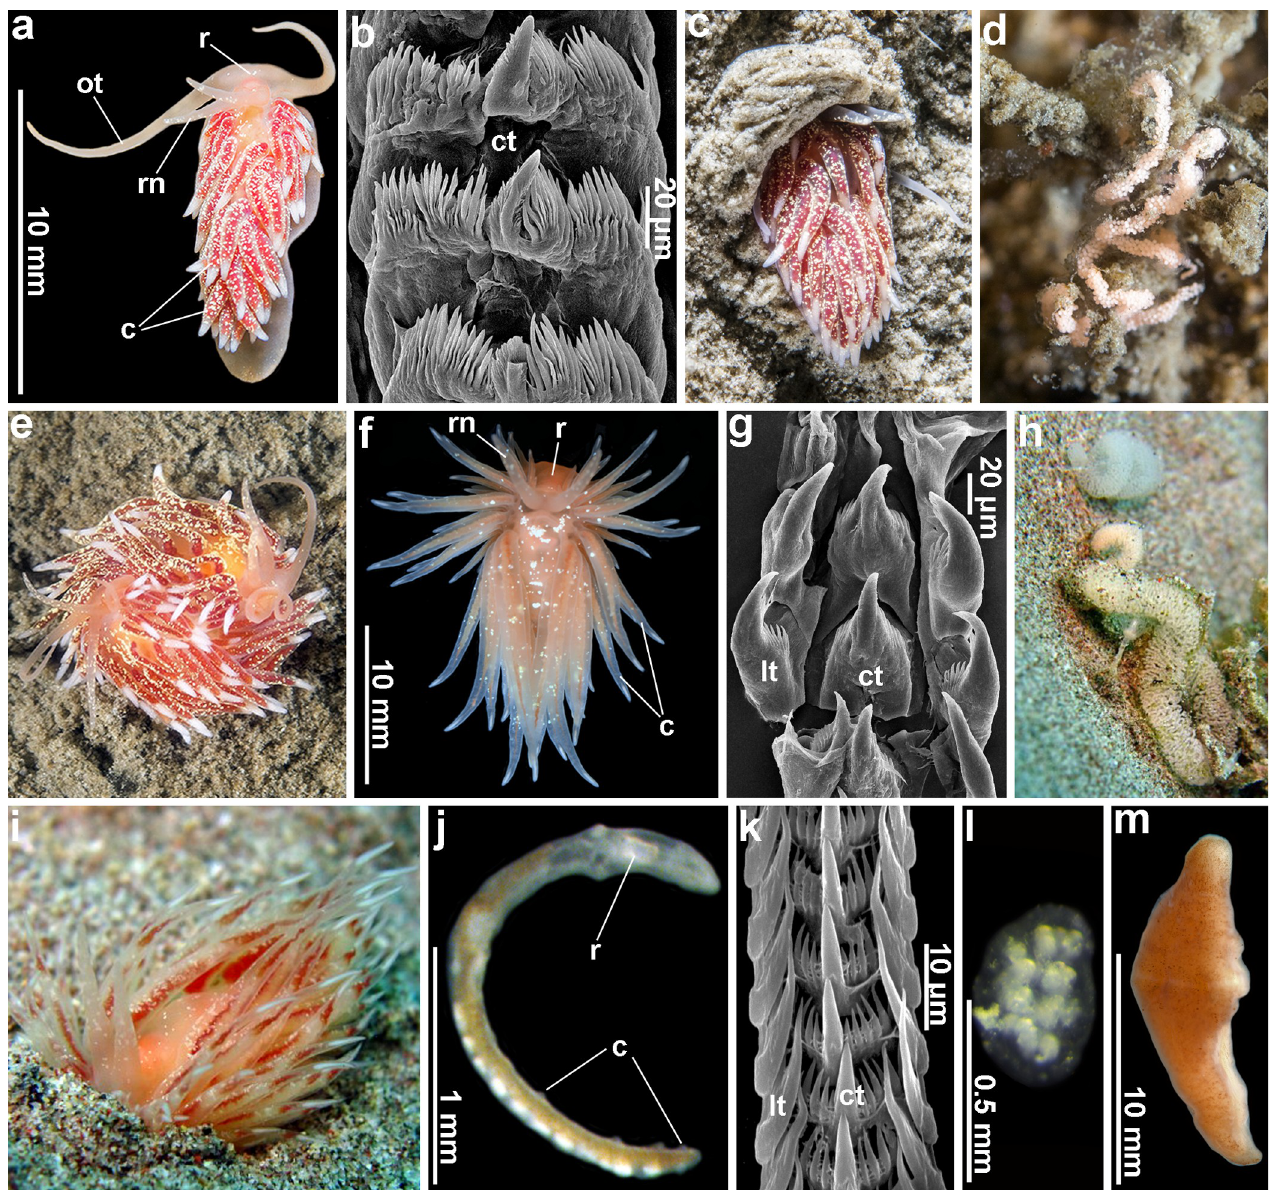
Fig 2. Nudibranch taxa Xenocratena suecica (A–E) and Cumanotus beaumonti (F–I) with facultative ability to burrow into soft substrata (C, I) compared to the highly simplified obligate infaunal Pseudovermis paradoxus (J–L) and Xenoturbella (M). Note the high external and behavioral similarity between the phylogenetically distantly related Xenocratena (A, C, E) and Cumanotus (F, I) and the drastic external differences between the phylogenetically closely related complex Cumanotus (F, I) and paedomorphic vermiform Pseudovermis (J). Radula (molluscan teeth) features, on the contrary, are very different between Xenocratena (B, note the absence of lateral teeth, lt) and Cumanotus (G, note the presence of lateral teeth, lt) and similar between Cumanotus (G) and Pseudovermis (K, note the presence of lateral teeth, lt). Both Xenocratena (D) and Cumanotus (H) are able to lay egg masses facultatively on soft substrata, whereas Pseudovermis (I) lays egg masses obligately on the soft substrate. Abbreviations: c, cerata (dorsal papillae); ct, central teeth of radula; lt, lateral teeth of radula; ot, oral tentacles; r, area below which radula is placed; rn, rhinophores (chemical sense organs). sequences were translated into amino acids for confirmation of the alignment. All newly gen- erated sequences were deposited in GenBank (Supporting information, S2 Table, highlighted in bold). All new and publicly available sequences were checked via BLAST searches in Gen- Bank (https://blast.ncbi.nlm.nih.gov/Blast.cgi) to verify identification and against potential